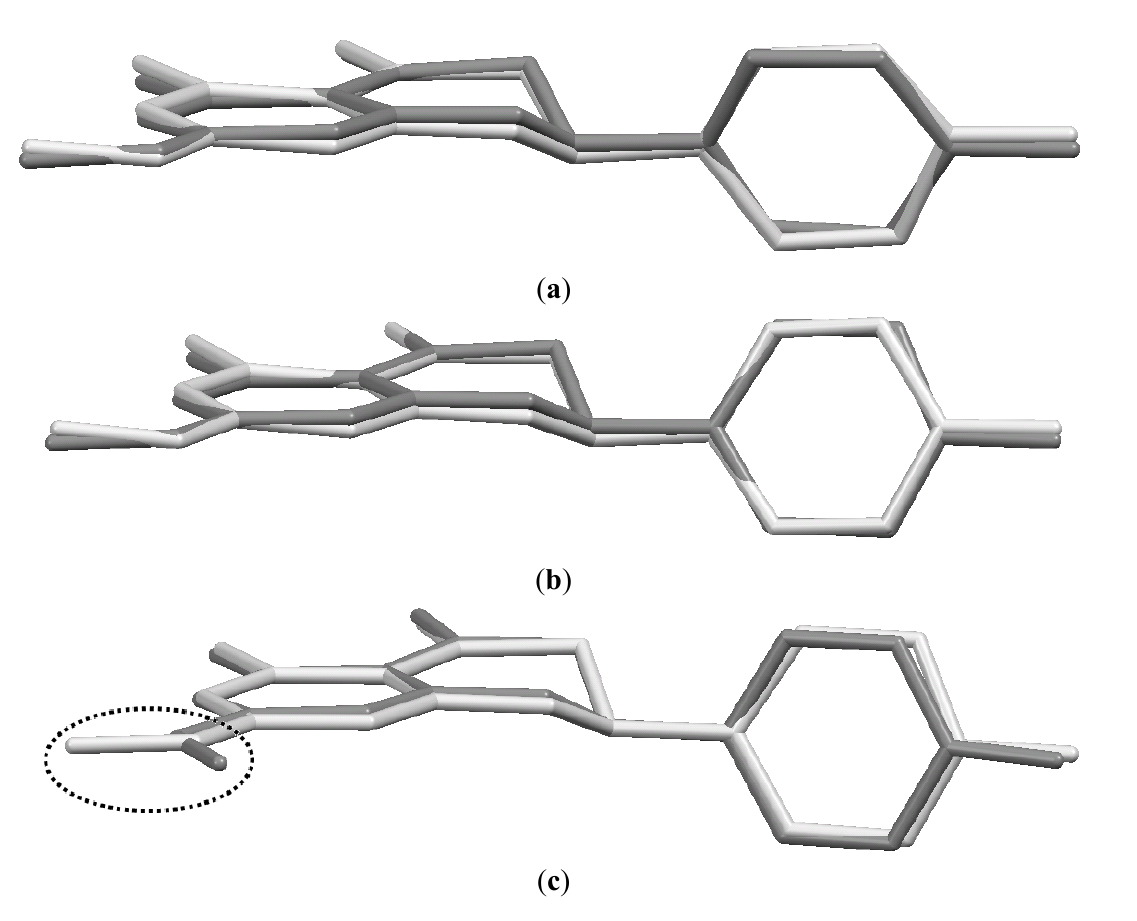
Figure 4. Superimposed structures for: ( a ) conformers A ( b ) conformers A sakuranetin-monohydrate + sakuranetin-dihydrate. Hydrogen atoms were omitted for clarity. [Color legend: light grey = A